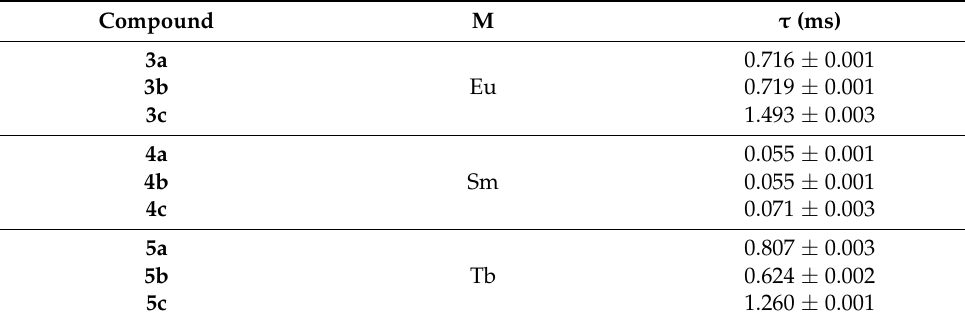
Table 4. The luminescence lifetime values for the lanthanide complexes 3a – 5c .